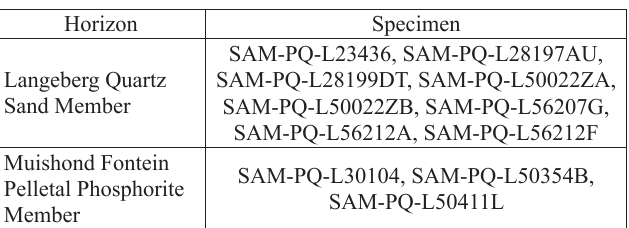
Table 4. Horizon of specimens of Tyto richae sp. nov. from the early Pliocene, Upper Varswater Formation at “E” Quarry, Langebaanweg, South